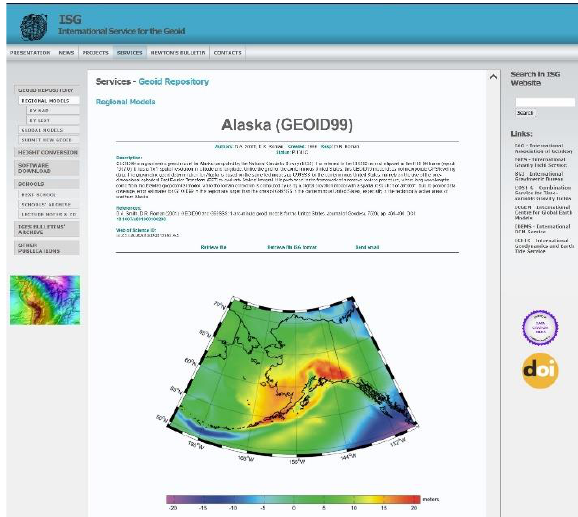
Figure 1. Overview of the products metadata for